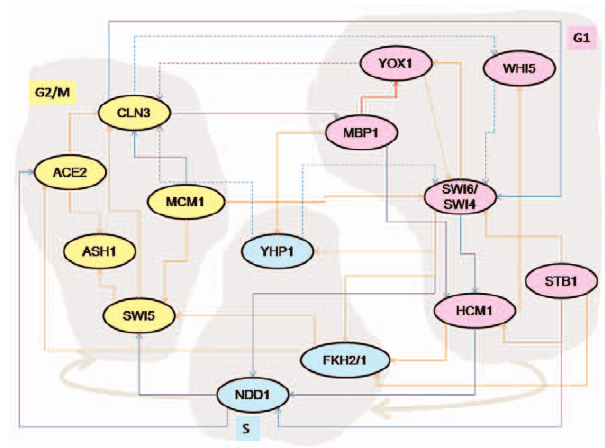
Figure 9. Transcription factor network of the yeast cell cycle inferred by Orlando et al. and Pramila et al. Solid lines indicate activating interactions and dashed lines indicate inhibitory interactions. The transcriptionfactorsofthecellcycletimelineareindicatedbythegrayblobs (G1 ? S ? G2/M). The interactions shown in red were correctly identified by ReBMM and the interactions shown in blue were not